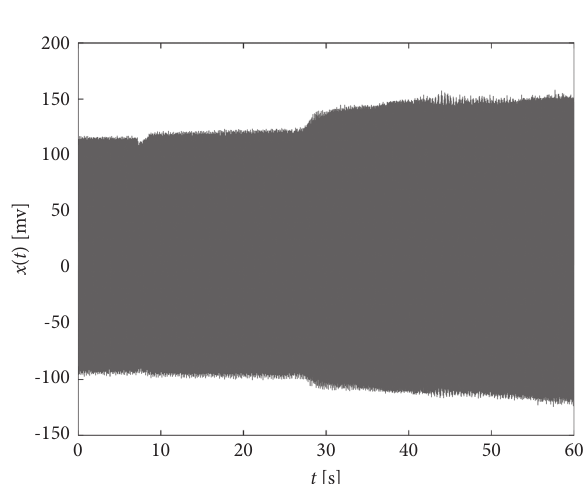
Figure 18: Observation signal of the propeller shaft.